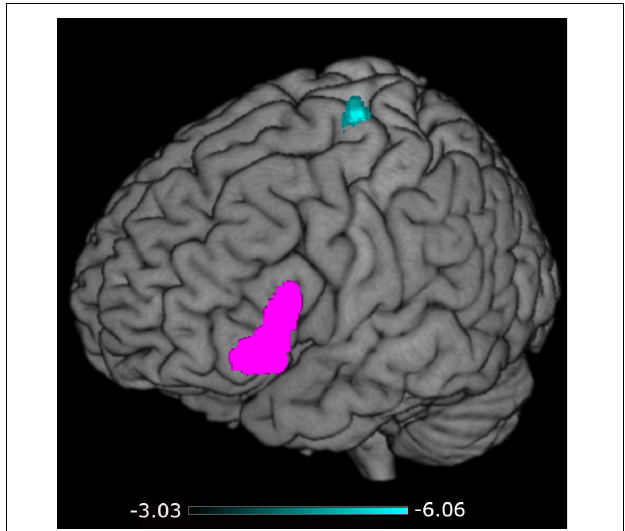
FIGURE 1 | Connectivity from the left inferior frontal gyrus (seed in pink) to the cluster in sensorimotor regions (in cyan). The color map indicates the strength (as t -values) of connectivity within the cluster.